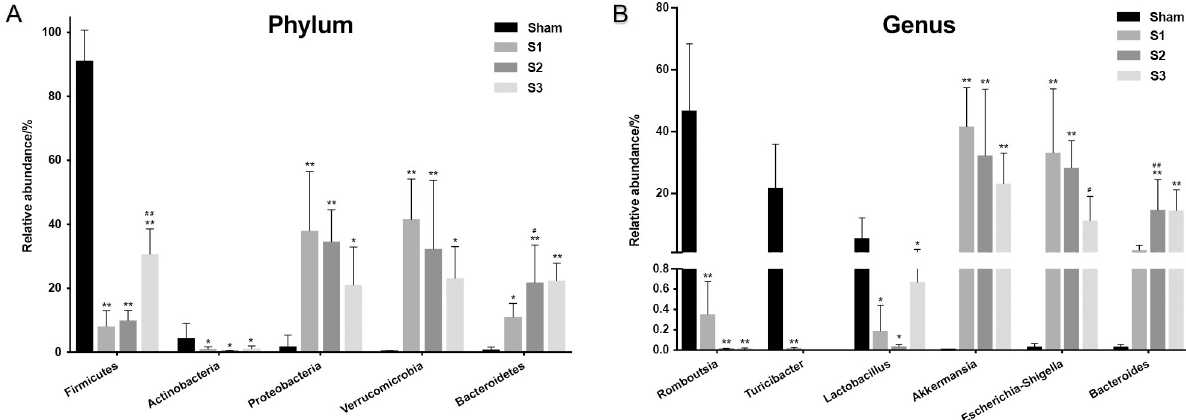
Fig 7. Comparison of relative abundances of the bacterial taxa exhibiting significant changes in sham and SBO rats. Relative abundances of the bacteria at Phylum level (A), Genus level (B) are shown in the figure. Data are presented as the mean ± SD, n = 5. � P < 0.05, �� P < 0.01 vs. Sham group; # P < 0.05, ## P < 0.01 vs. the preceding group.